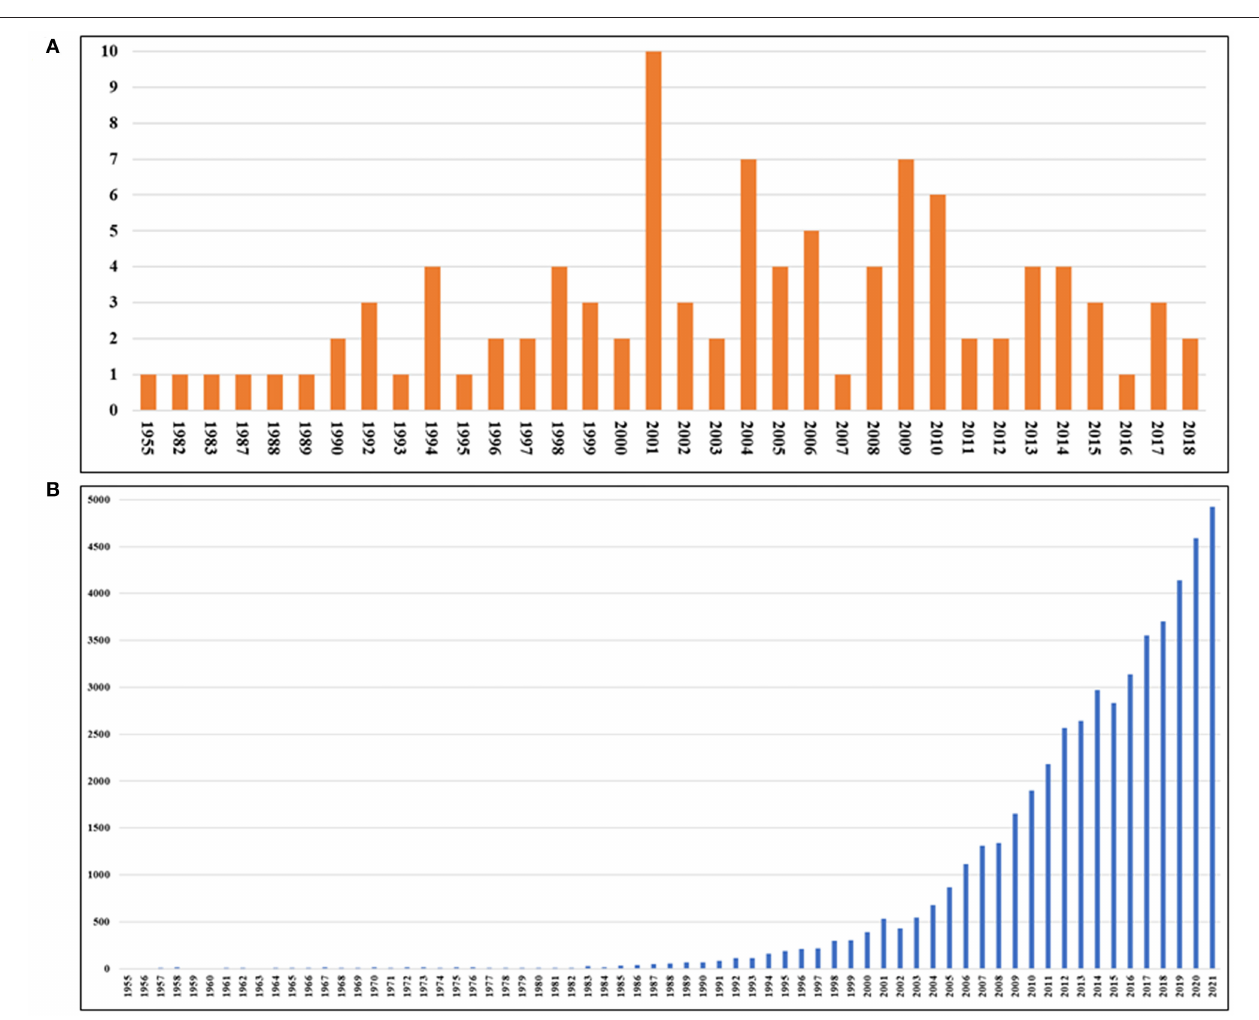
FIGURE 1 | The year of publication (A) and total citation frequency each year of all articles (B) of the 100 most-cited articles in the field of